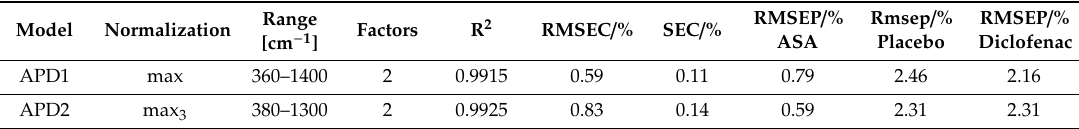
Table 4. PLSR calibration and prediction model performance parameters for inline predictions of Table 2 containing